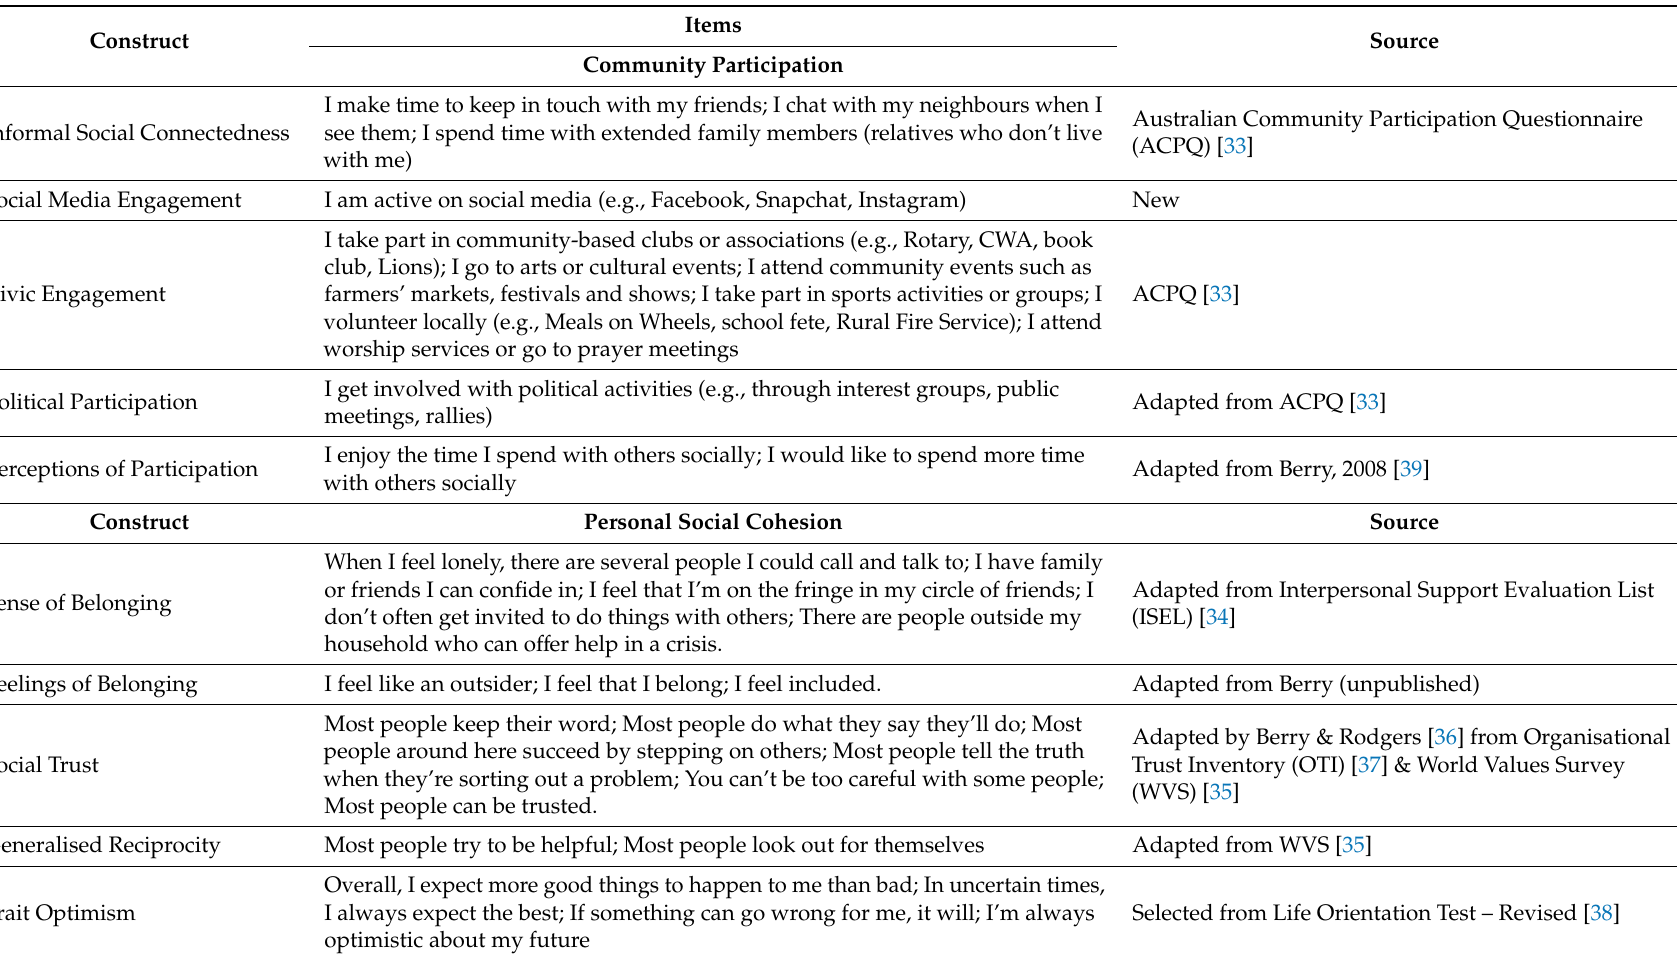
Table 1. Social capital measures used within the Northern NSW Community Recovery after Flood